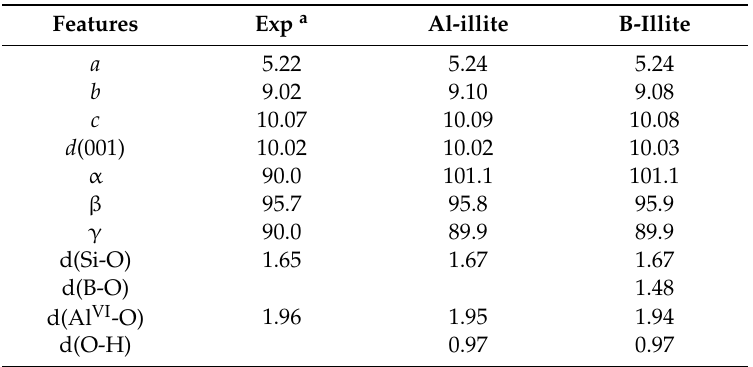
Table 3. Cell parameters and select interatomic distances of Al-illite and B-illite unit cells (distances in Å and angles in ◦ ).